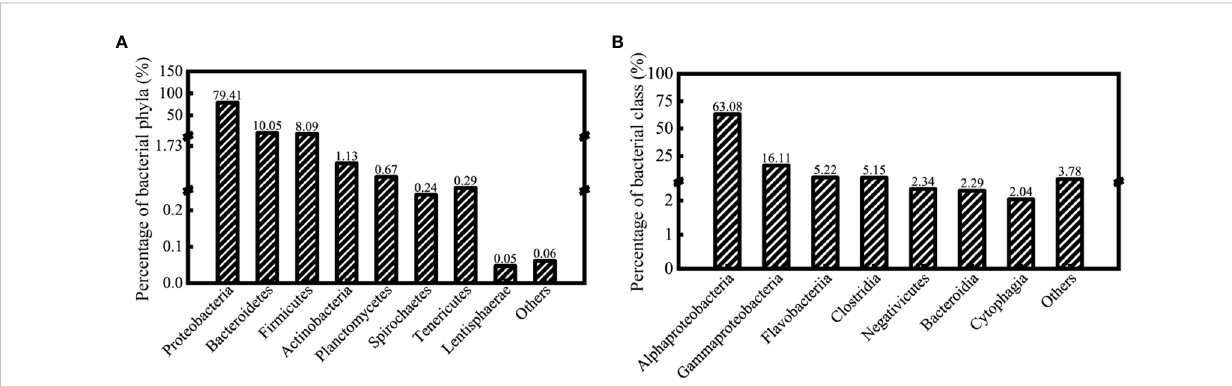
FIGURE 2 The operational taxonomic units (OTUs) identi fi ed under the algal-bacteria co-culture system that was assigned to major bacterial phyla (A) and classes (B) (97% similarity cutoff).